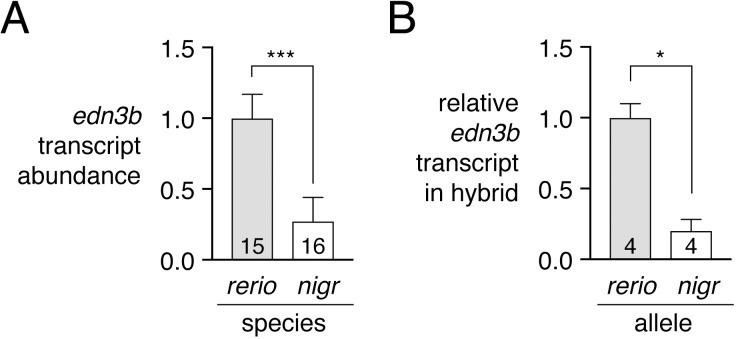
Lower expression of D. nigrofasciatus edn3b relative to D. rerio edn3b.(A) edn3b was expressed at lower levels in skin of D. nigrofasciatus than D. rerio (F1,29 = 48.6, P<0.0001) during adult pattern formation. (B) In hybrid fish, D. nigrofasciatus edn3b alleles were expressed at lower levels than D. rerio edn3b alleles (paired t3 = 4.6, P<0.05). Shown are means±SE. Values within bars indicate sample sizes.